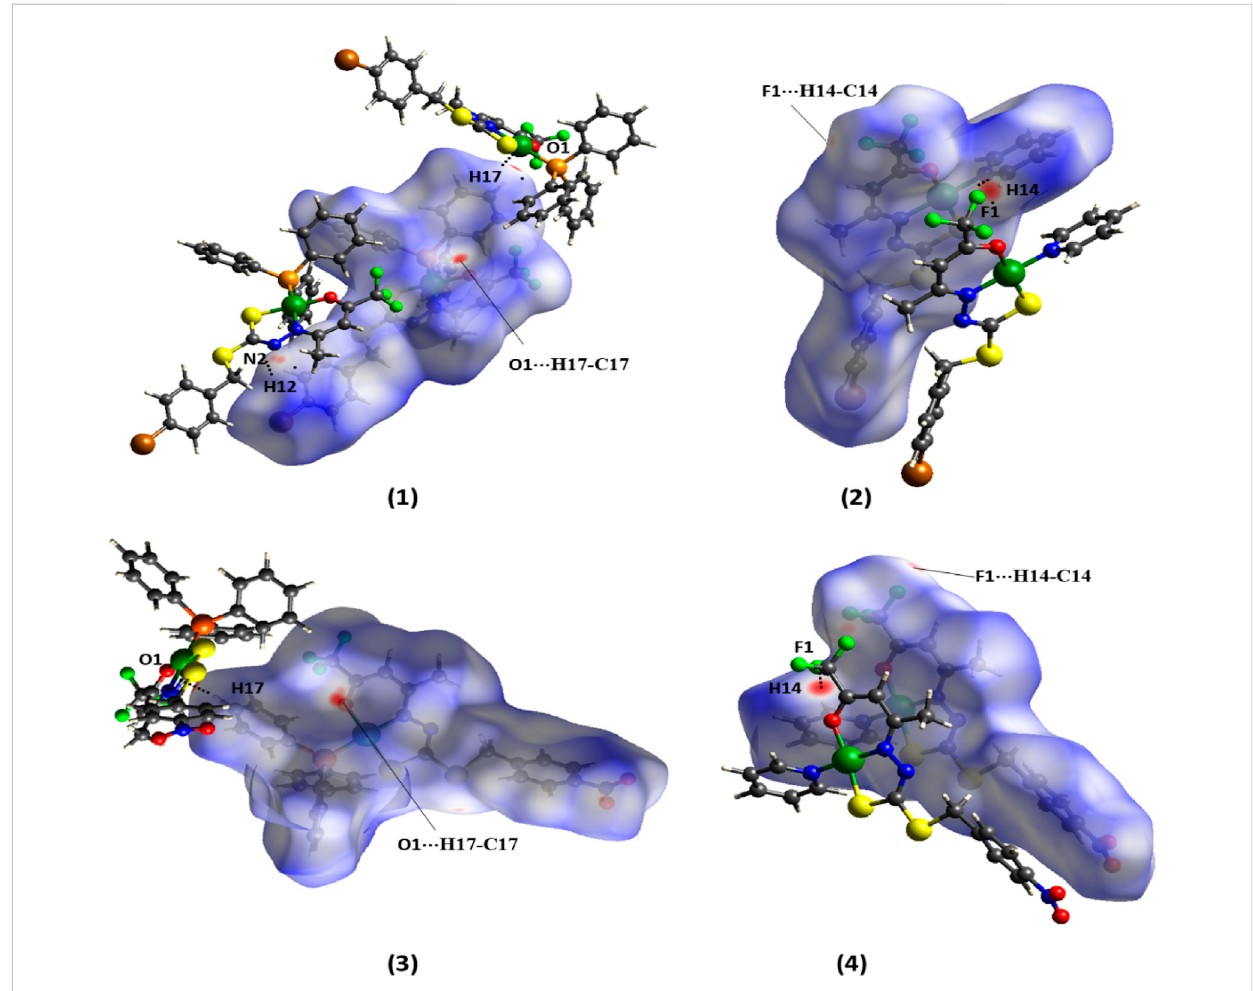
Hirshfeld surface of the complexes (1 – 4) mapped with d norm